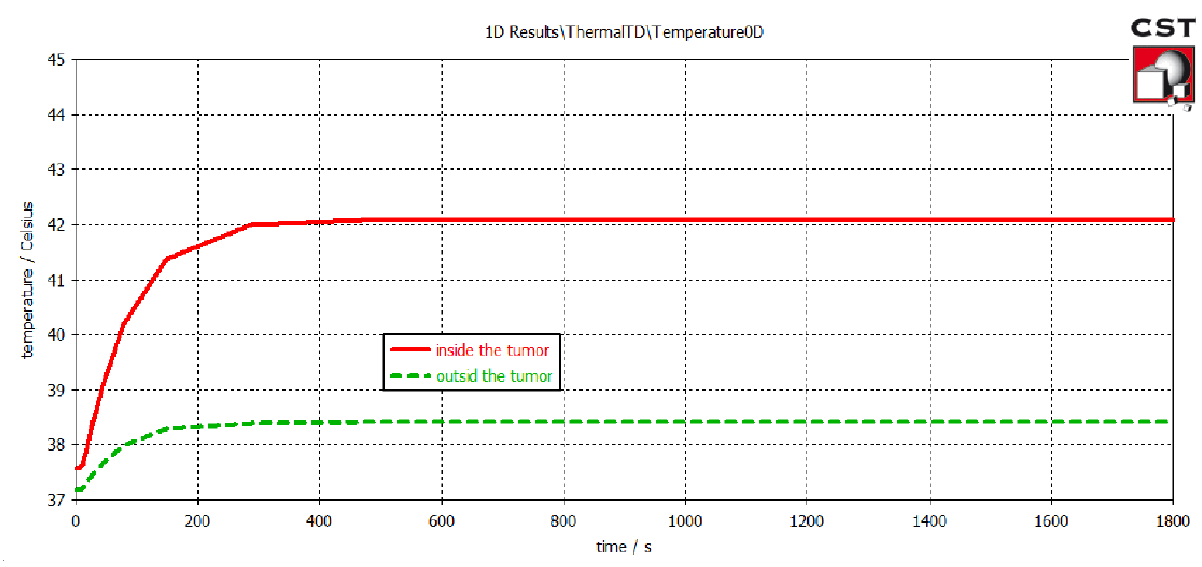
Figure 13: Temperature distribution during hyperthermia with GNPs at 915